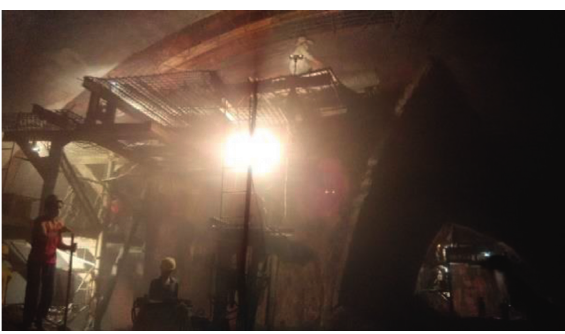
Figure 9: Photo of CD method construction in Malin